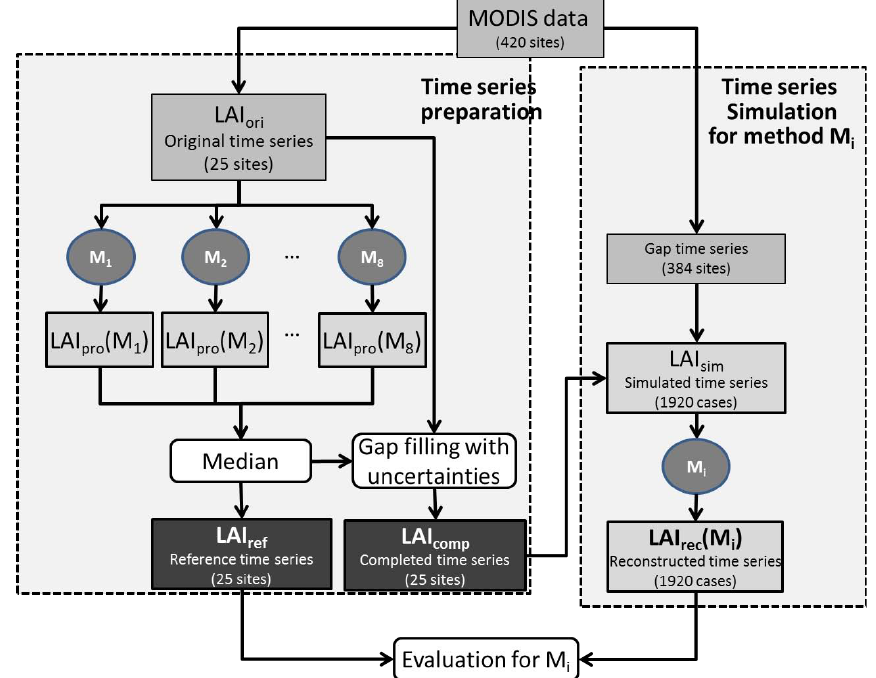
Fig. 1. Flow chart describing the approach used. M i corresponds to method i within the 8 investigated. LAI rec (M i ) corresponds to the reconstructed time series based on method M i